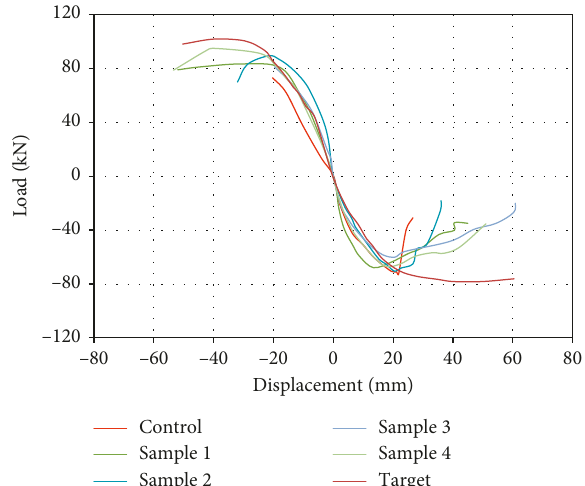
Figure 16: Envelope curves of the load-displacement test results.